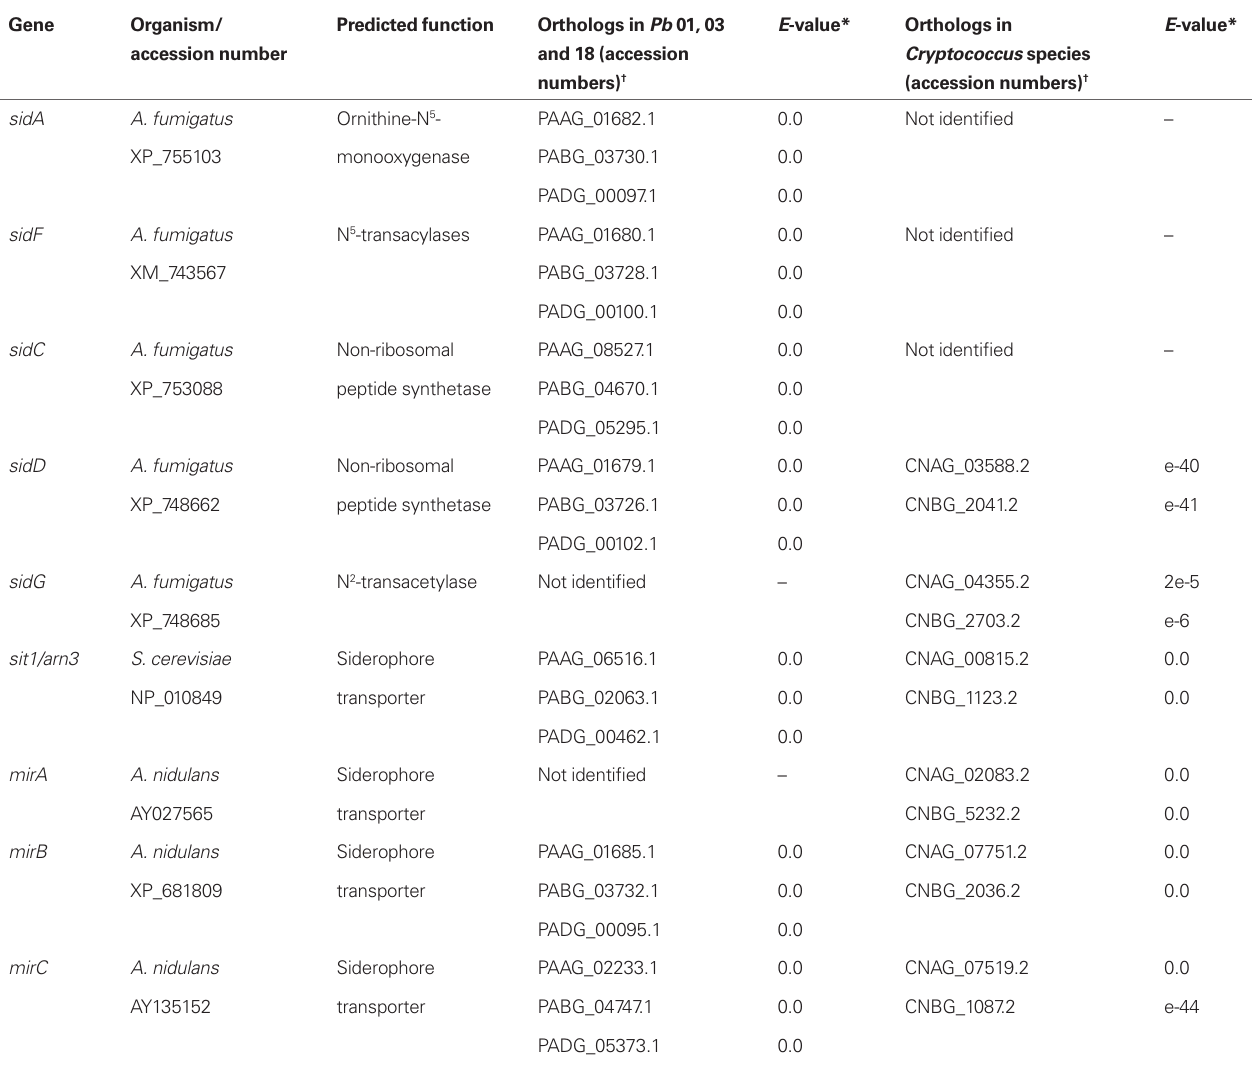
Table 2 | Orthologs to genes related to siderophore biosynthesis and to iron uptake by the non-reductive siderophore transport system in P. brasiliensis and Cryptococcus species